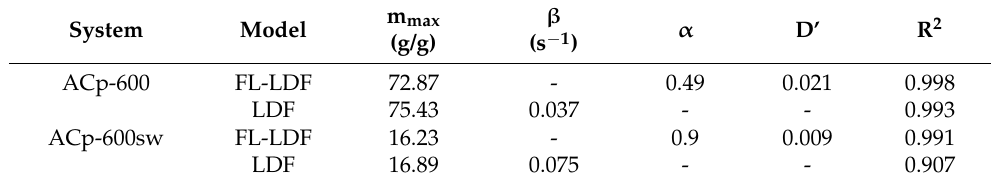
Table 2. Parameters of the FL-LDF and LDF model for ACp-600 in oil and oil/seawater systems. System